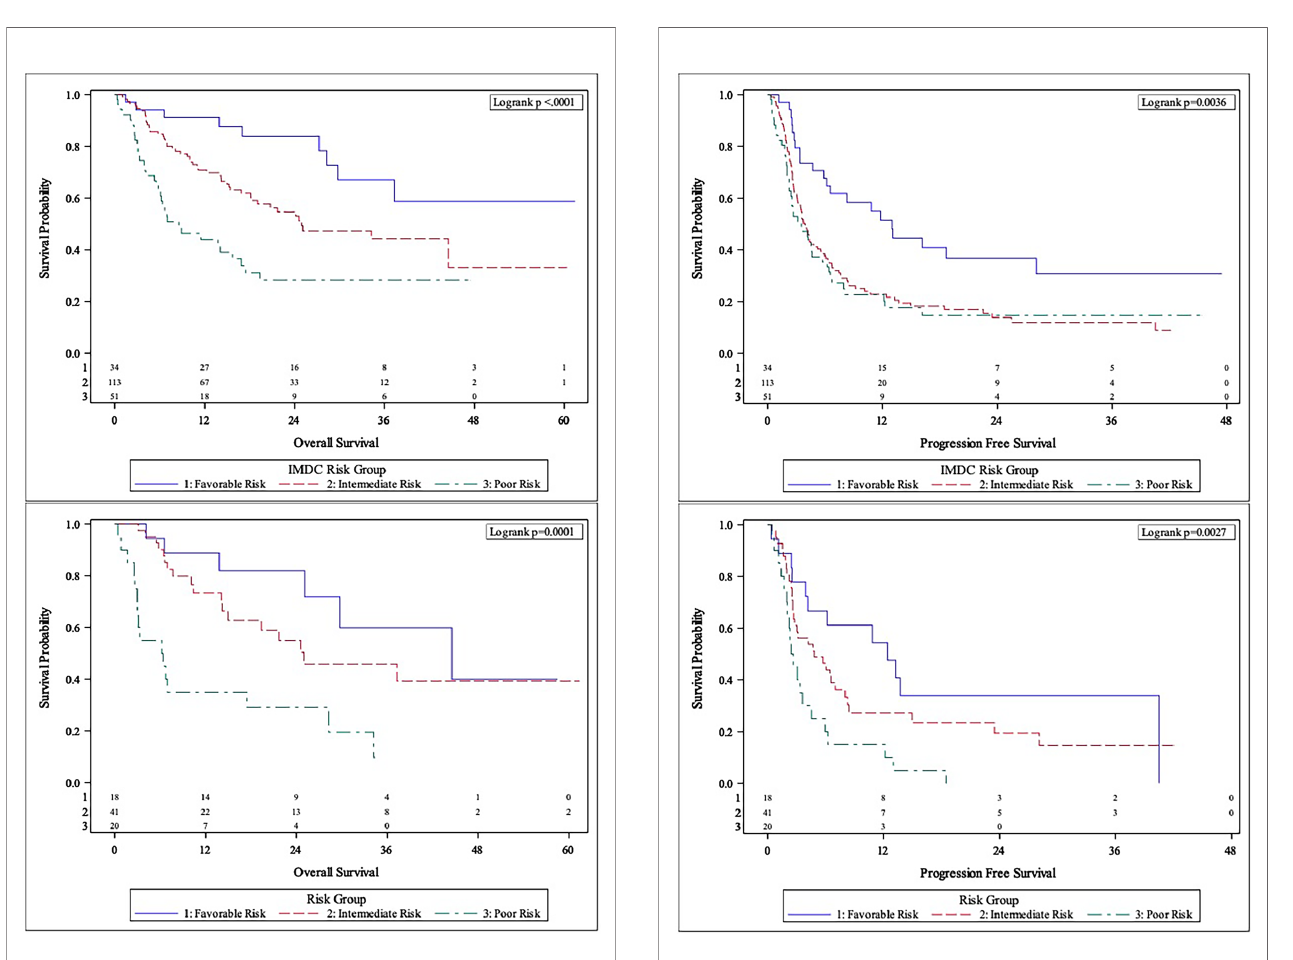
FIGURE 2 | Comparison of Kaplan-Meier curves between IMDC risk groups (Top Panel) and body composition risk groups (Bottom Panel) for progression-free survival (PFS).